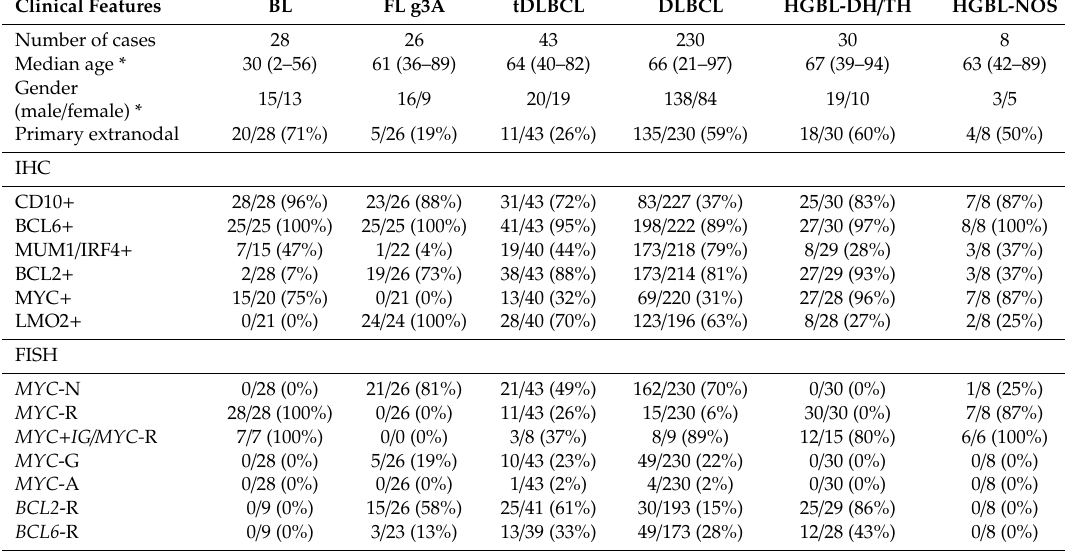
Table 1. Clinical and immunohistochemical features, and MYC gene alterations detected by fluorescence in situ hybridization (FISH) in 365 cases of large B-cell lymphomas